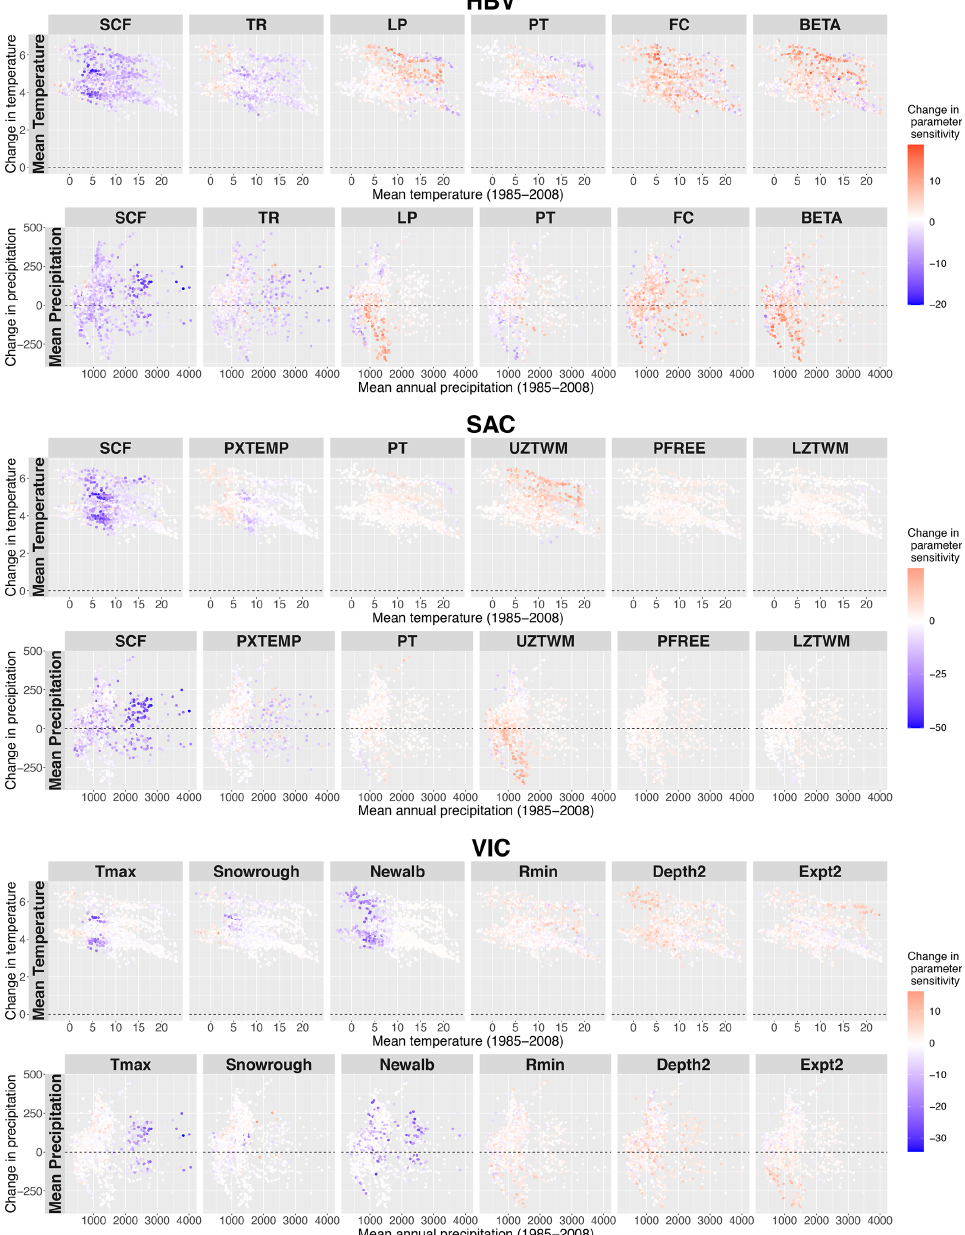
Figure C3. Change vs. historical values in mean temperature and mean precipitation over 605 basins, with change in parameter sensitivity indicated using discharge timing as the target variable. All three climate scenarios are shown together in each subplot. Parameter sensitivity for the historical period is expressed as dot size. Change in parameter sensitivity in colour. Red colours indicate an increase in sensitivity, blue a